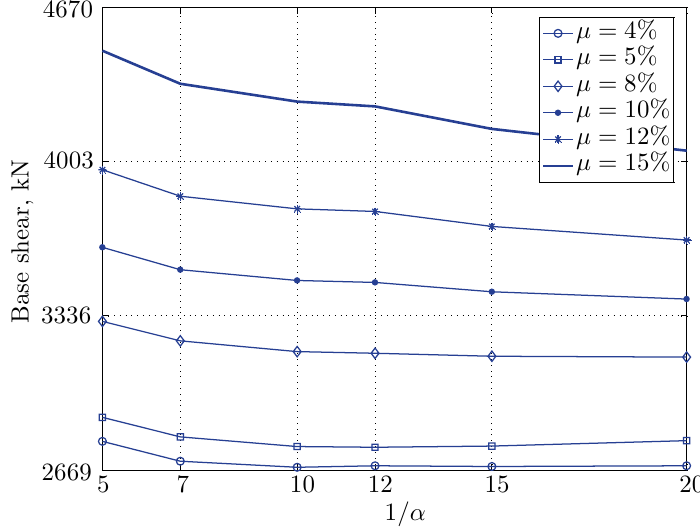
Figure 23. Maximum base shear for various isolation system parameters (Lexington dam).